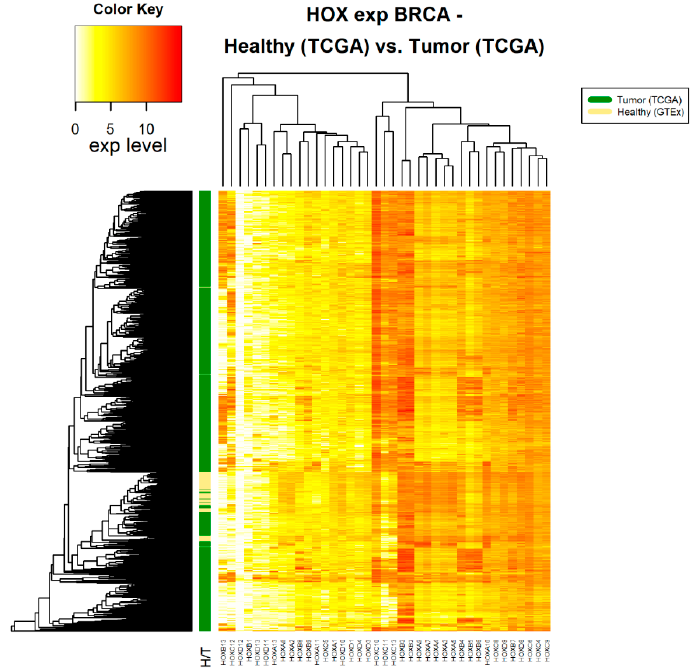
Figure 1. HOX gene expression in healthy and tumor breast tissue samples. The source of expression data of both healthy and tumor samples is TCGA.